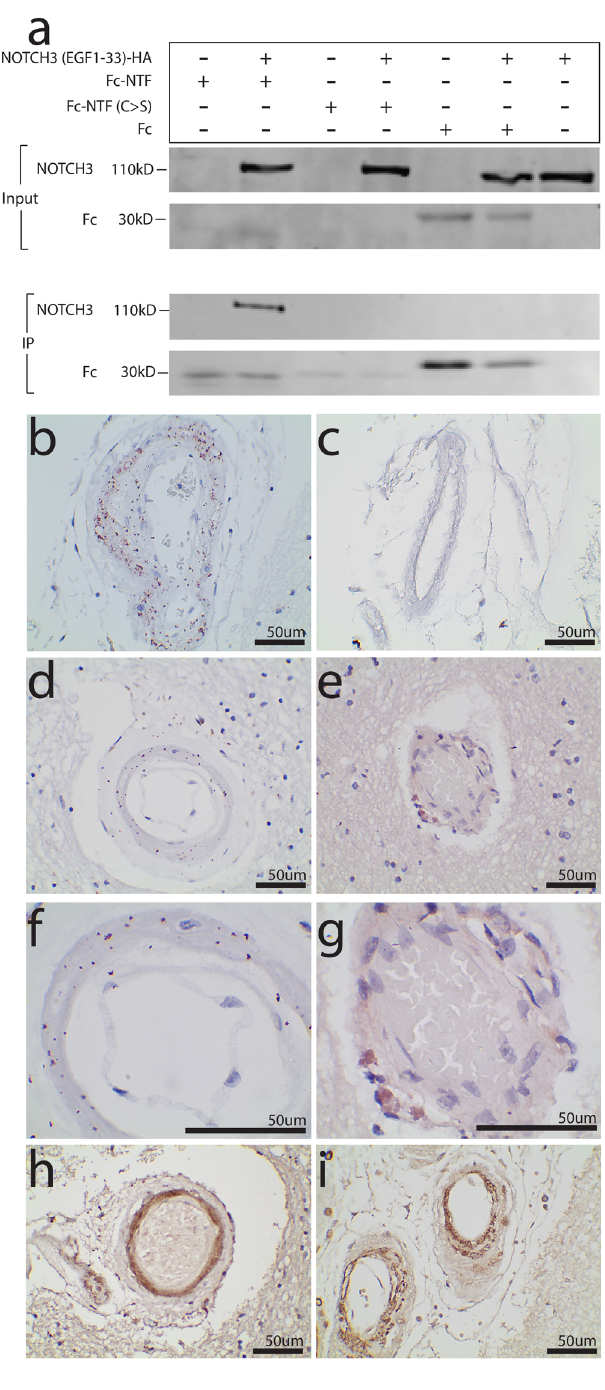
Fig. 3 NTF forms complexes with NOTCH3 detectable in CADASIL vessels. Fc-NTF co-immunoprecipitated with NOTCH3-HA ( a ). A version of Fc-NTF with all cysteines mutated to serine (Fc-NTF C > S) and the Fc tag alone were unable to pull down NOTCH3-HA. Experiments were performed at least three times using distinct samples with similar